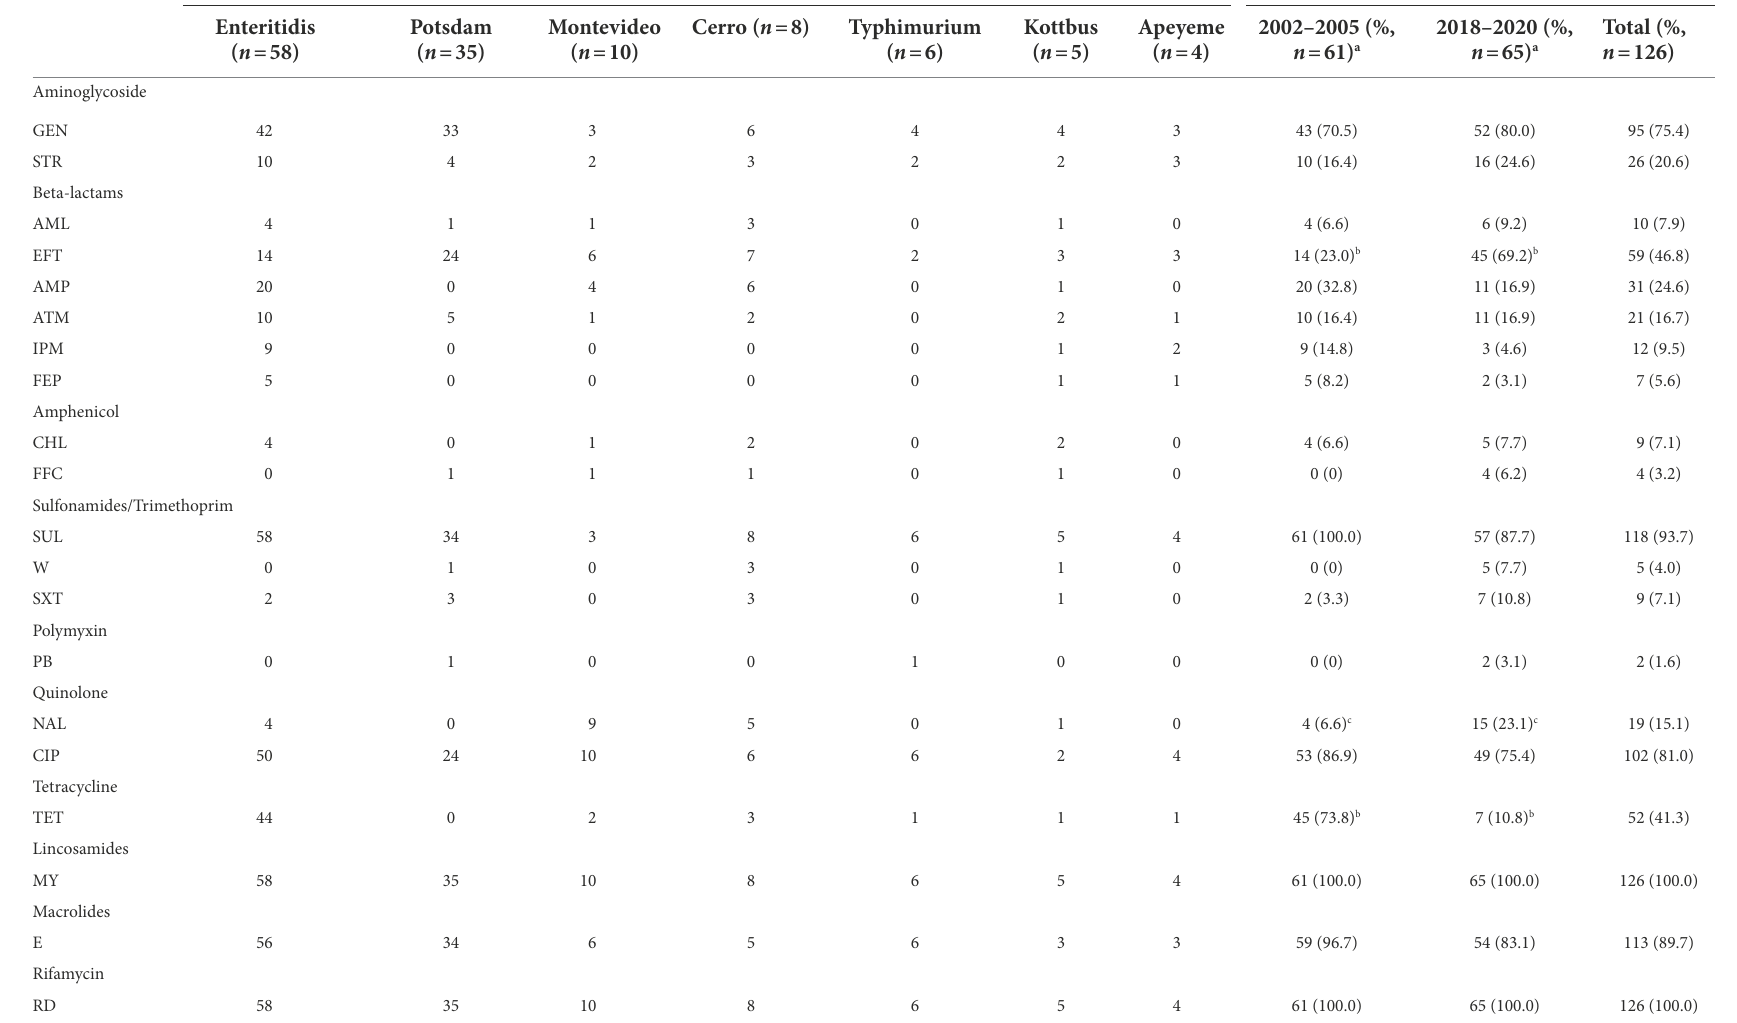
Numbers represent the isolates that were resistant to the corresponding antimicrobial agents for different serotypes or different times. SUL, sulfadiazine; CIP, ciprofloxacin; GEN, gentamycin; EFT, ceftiofur; TET, tetracycline; AMP, ampicillin; STR, streptomycin; ATM, aztreonam; NAL, nalidixic acid; IPM, imipenem; SXT, trimethoprim/sulfamethoxazole; AML, amoxicillin; CHL, chloramphenicol; FEP, cefepime; W, trimethoprim; FFC, florfenicol; and PB, polymyxin B. a Indicates the overall difference in AMR rates between the two periods (two-way ANOVA test, p < 0.0001). b Indicates a significant difference in AMR rates of specific antimicrobial agents between the two periods (Chi-square test, p < 0.0001). c Indicates a significant difference in AMR rates of specific antimicrobial agents between the two periods (Chi-square test, p <